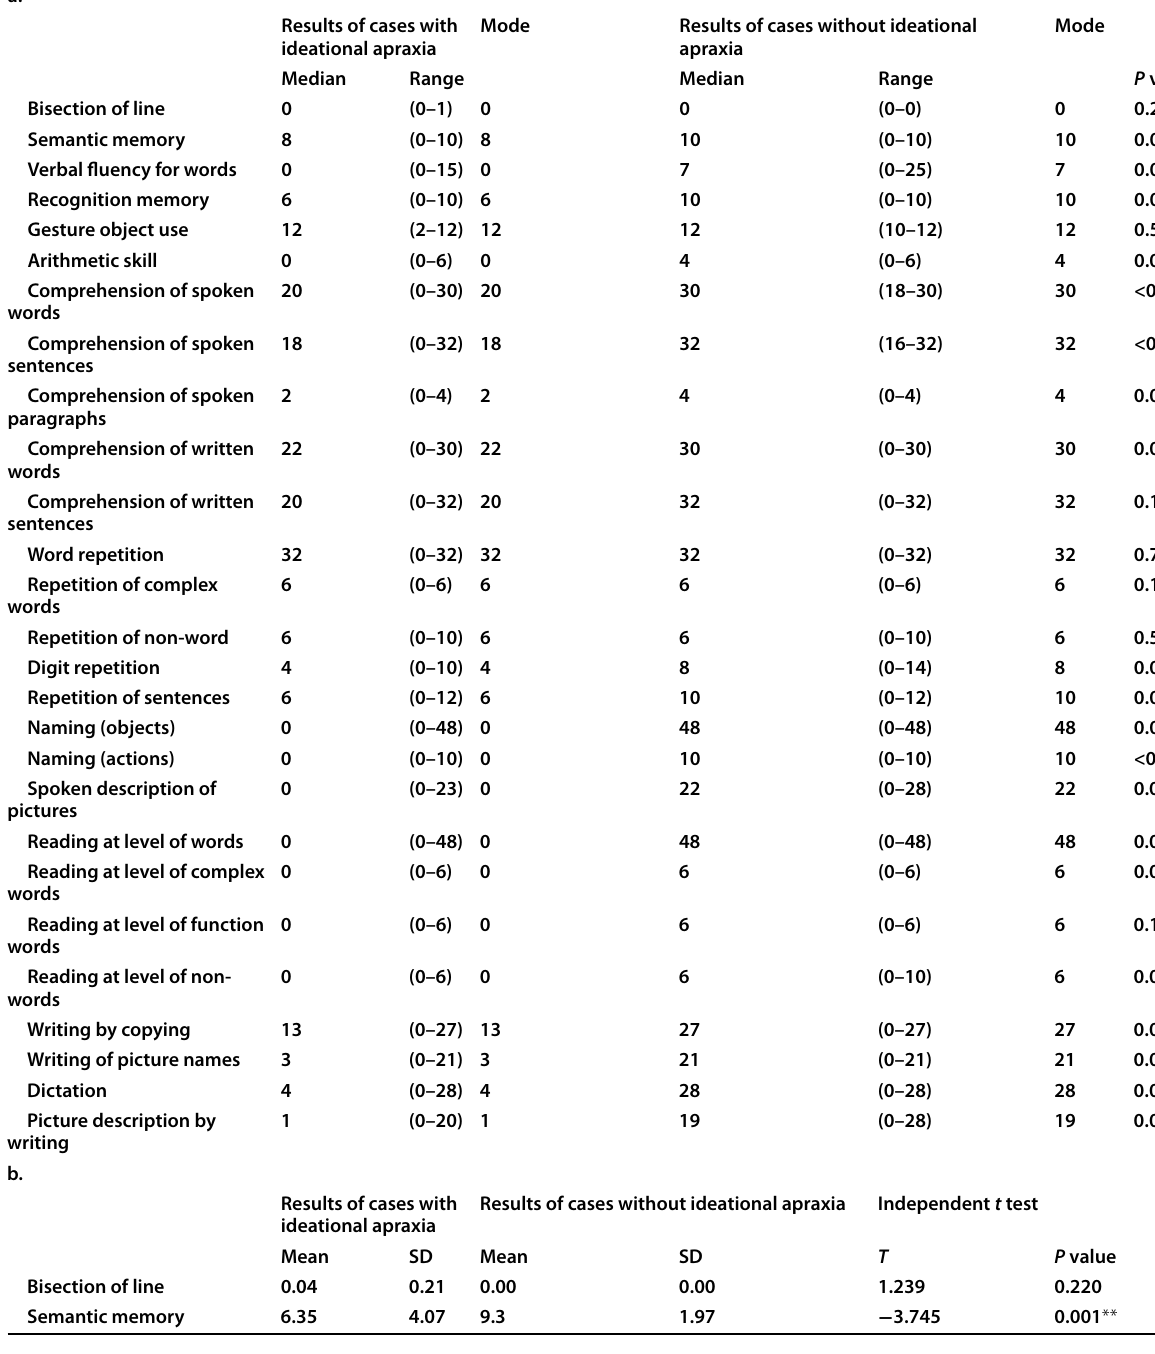
Table 2 Comparison between patients with ideational apraxia and without ideational apraxia regarding scores of aphasia test. Table 2 (a) that was statistically analyzed using the median shows that there was a significant difference between patients with ideational apraxia and patients without ideational apraxia in the scores of aphasia test in word fluency, semantic and recognition memories, arithmetic, spoken word, sentence and paragraph comprehension, written word comprehension, repetition of digit strings, sentence repetition, naming tasks, spoken picture description, and reading and writing tasks. Table 2 (b) that was statistically analyzed using the mean revealed that there was a significant difference between patients with ideational apraxia and patients without ideational apraxia in the scores of aphasia test in sematic and recognition memories, arithmetic, spoken word, sentence and paragraph comprehension, repetition of digit strings, sentence repetition, naming tasks, reading words, and writing